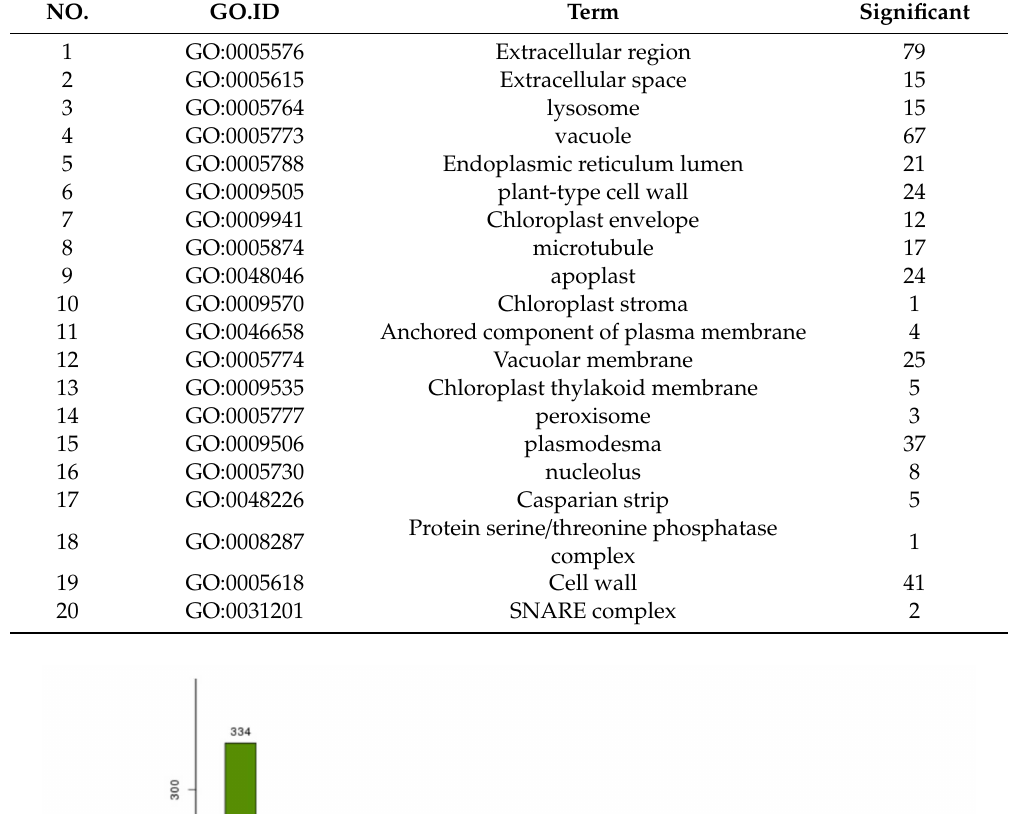
Table 5. GO analysis of DEGs significantly annotated in the cellular component (CC).